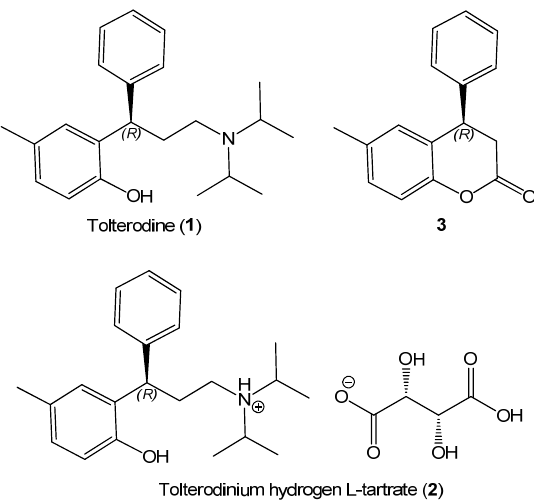
Figure 1. Structures of ( R ) ‐ tolterodine ( 1 ), its hydrogen L ‐ tartrate salt 2 , and precursor 3 .